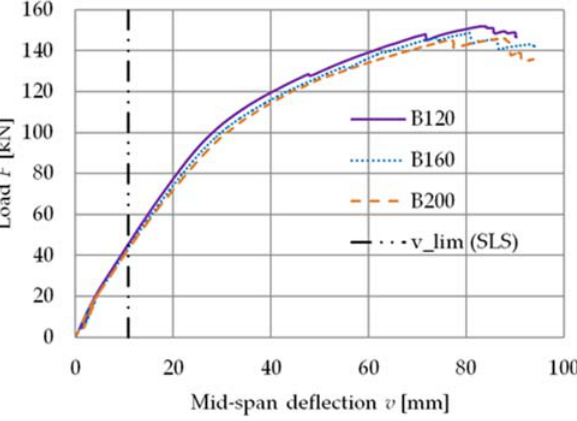
Figure 6. The load versus deflection response for the B120, B160, and B200 beams.